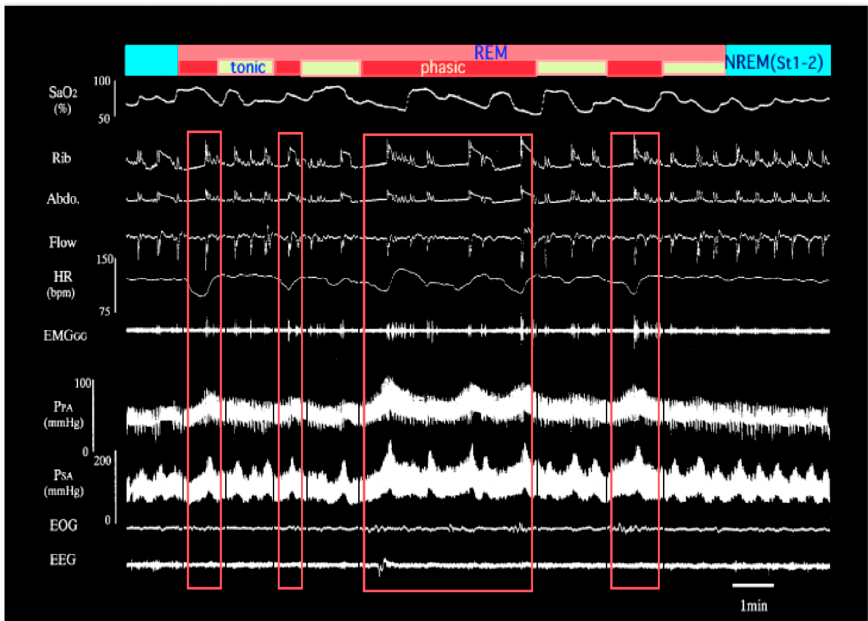
Figure 1. Representative polysomnographic recording during transition from non-REM (NREM) to REM to NREM sleep in an obstructive sleep apnea (OSA) patient with daytime pulmonary hypertension (PH) (adapted from [14]). Increase in pulmonary artery pressure is more exaggerated during REM sleep than NREM sleep. Moreover, the rapid rise of pulmonary arterial pressure (PAP) associated with the appearance of phasic REM and its recovery to the initial level immediately after the disappearance of REM are evident. The record of the area surrounded by the red square lines represents REM sleep. SpO 2 ; arterial oxygen saturation by pulse oximeter, Rib; rib cage movement, Abdo; abdominal movement, Flow; nasal airflow, HR; heart rate, EMG GG ; genioglossal electromyogram, P PA ; pulmonary artery pressure, P SA ; systemic artery pressure, EOG; electrooculogram, EEG; electroencephalogram. Phasic; phasic REM, tonic; tonic REM.